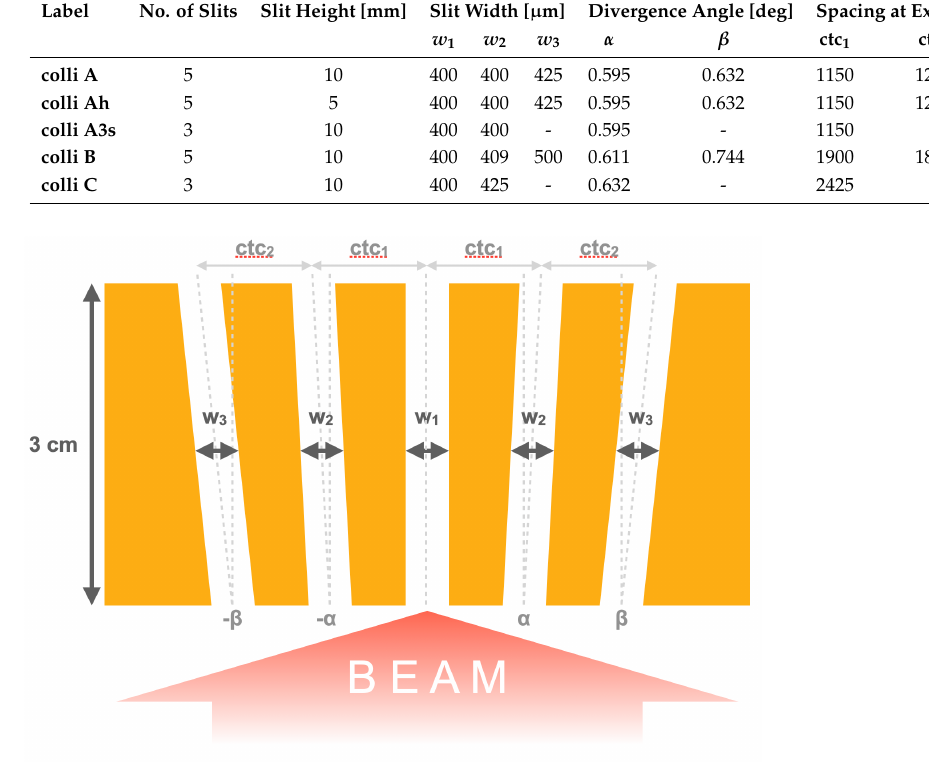
Figure 1. Schematic of the collimator used for minibeam generation illustrating the slit widths and divergence angles listed in Table